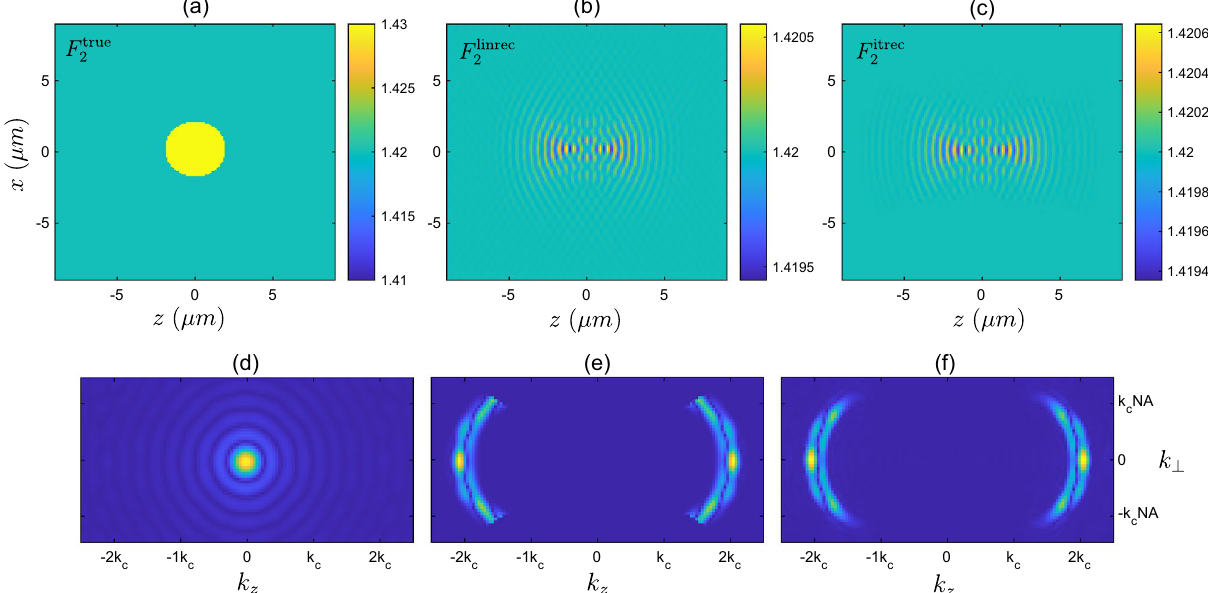
Figure 5. ( a ) Refractive index corresponding to the scattering potential of the low contrast disk sample F 2 . ( b ) Refractive index corresponding to the linear reconstruction F linrec 2 . ( c ) Refractive index corresponding to the iterative solver reconstruction F itrec 2 . ( d ) Magnitude of Fourier transform, |˜ F true 2 ( k ) sample. ( e ) Magnitude of Fourier transform of true sample after being filtered |˜ F true 2 ( k ) of the Fourier transform of the reconstructed sample provided by the iterative solver, |˜ F itrec 2 ( k )